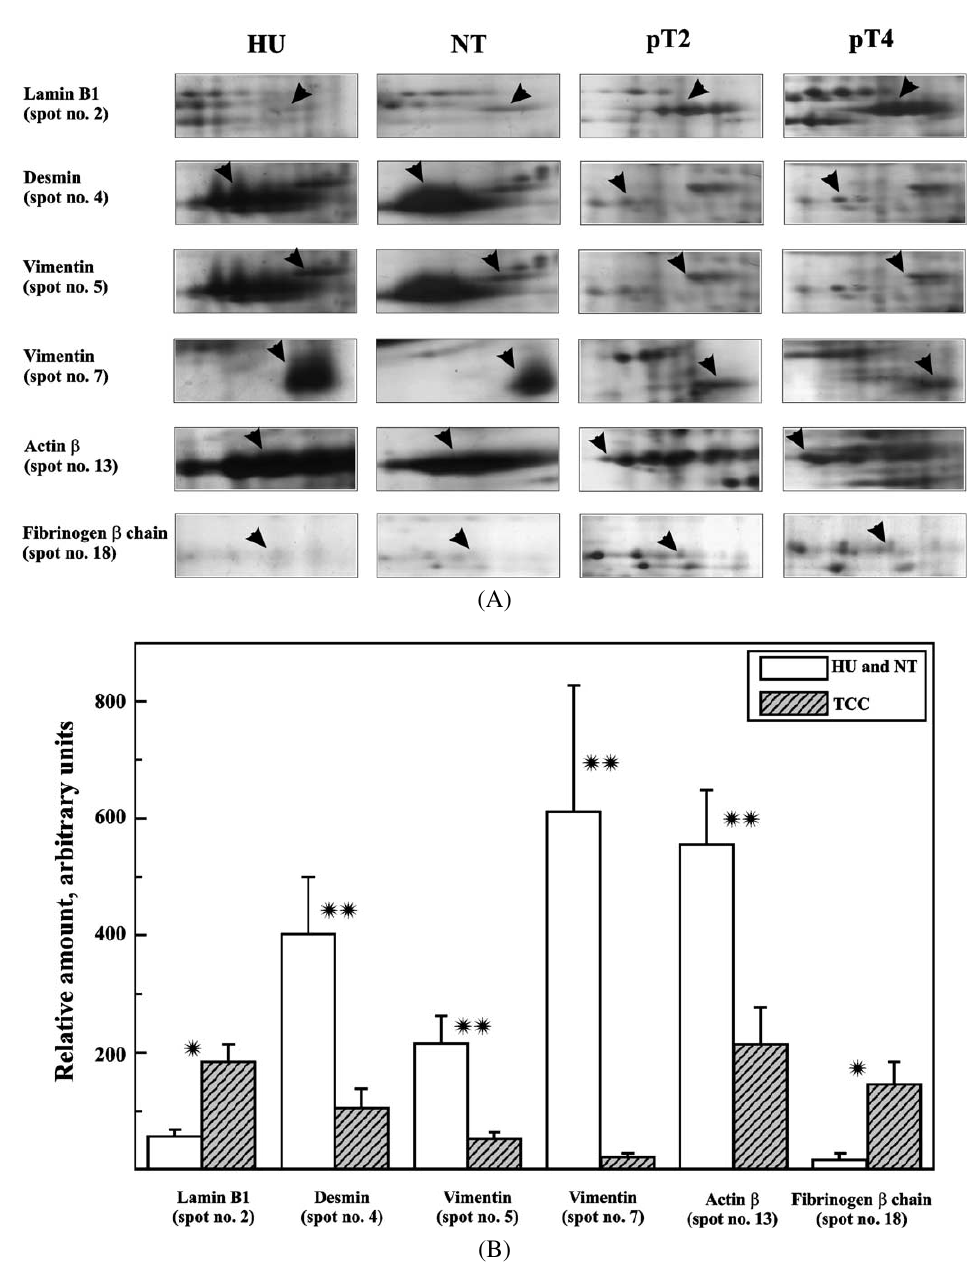
Fig. 2. Identified NM proteins grouped in pattern A that exhibit a significant deregulation in TCC. (A) Magnified sections of 2D silver-stained gel maps reported in Fig.1; (B) comparison of the relative amounts. The ordinates represent the mean ± standard error (SEM). ∗ P < 0 . 01, ∗∗ P < 0 .